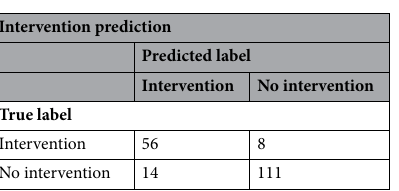
Table 2. Confusion matrix for the optimal probability threshold (Youden’s